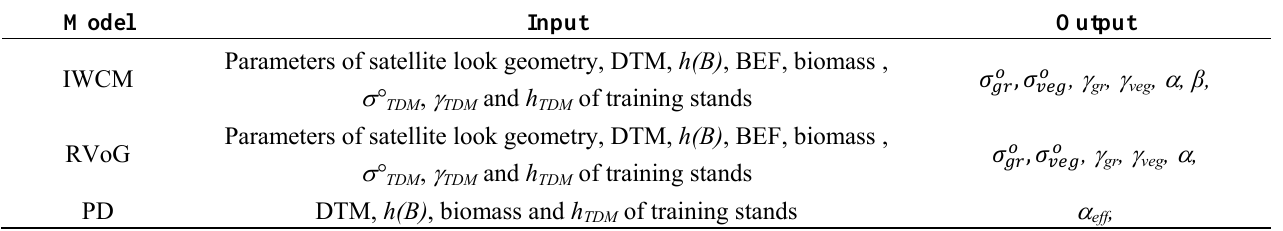
Table 2. Input and output of the model training phase for the three